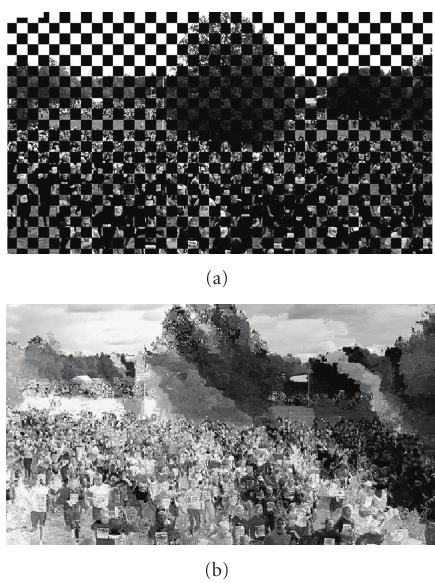
Figure 4: Decoding without knowing the watermark extraction key on the crowd sequence in case of MJPEG (a) and H.264 (b).